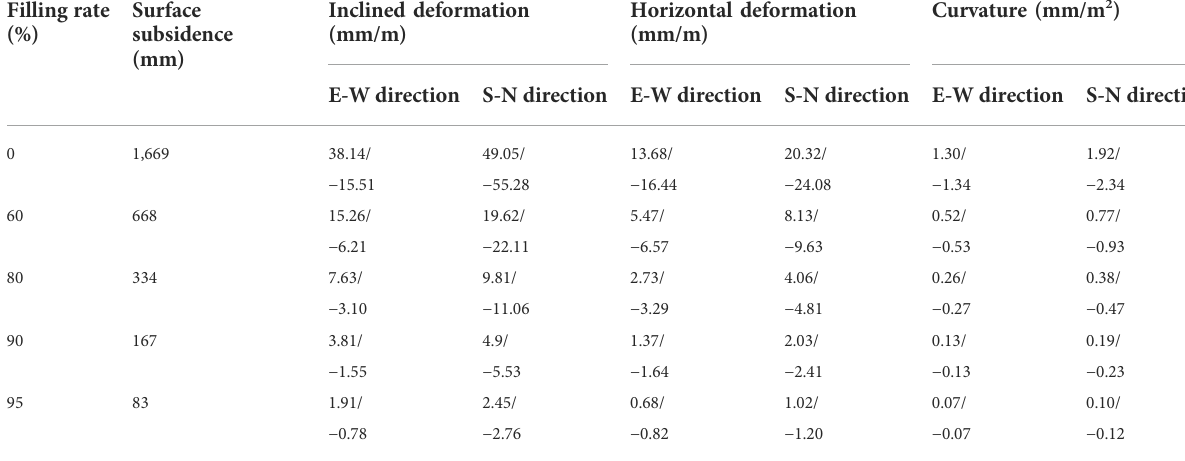
TABLE 2 Surface deformation characteristics affected by the fi lling